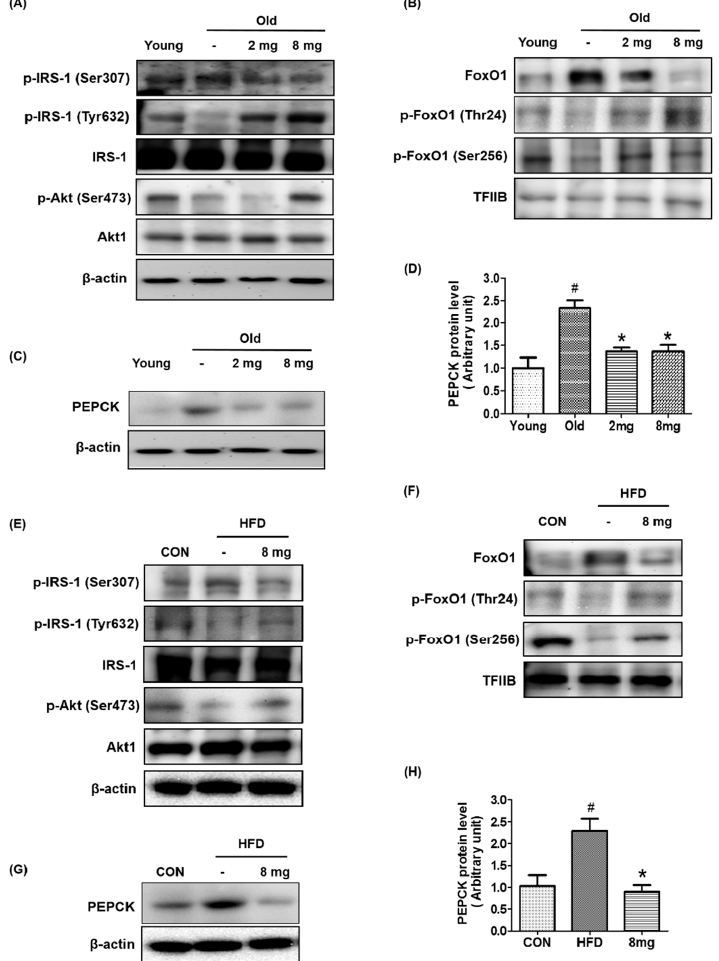
Figure 3. Effect of MLB on the insulin signaling pathway. The protein levels related to insulin signaling were analyzed by western blotting in the liver of ( A – C ) aged rat ( n = 4–5 per group) and ( E – G )